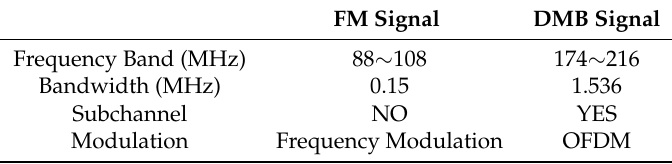
Table 3. Specification of FMand Digital Multimedia Broadcasting (DMB)